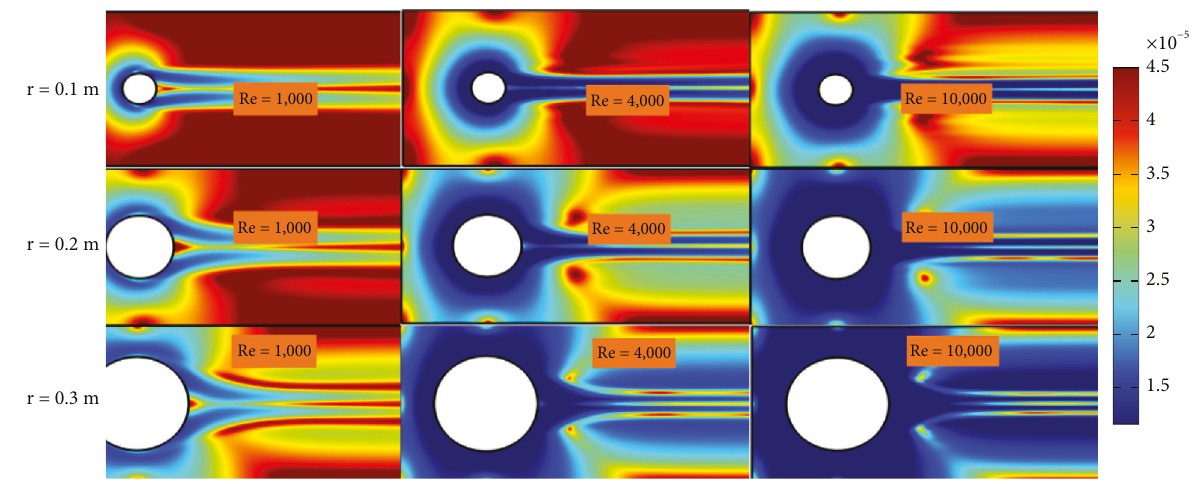
Figure 14: Contours of apparent viscosity around the heated cylinder for n � 0 .